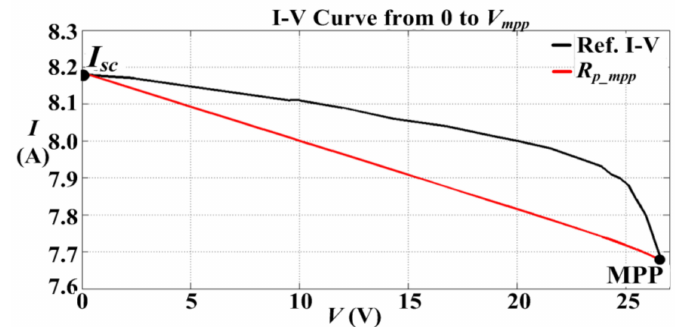
Figure 4. Ref. I-V curve and I-V curve at R p_mpp